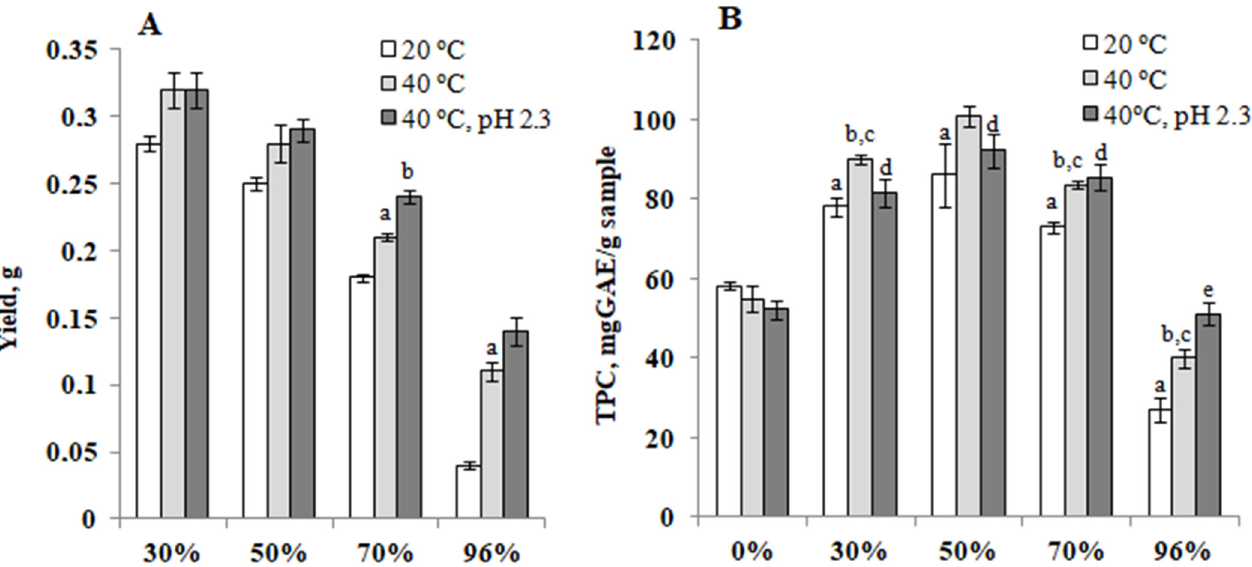
Figure 6. ( A )—The extract yield (g) per 1 g of dry powder of leaves depending on the temperature and pH. a —Significantly different from the water-ethanol extracts, 20 ◦ C ( p < 0.05); b —significantly different from the water-ethanol extracts, 40 ◦ C ( p < 0.05). ( B )—Content of phenolic compounds (mg GAE/g of extract) in water-ethanol extracts of yacon leaves, depending on temperature and pH. a —Significantly different from the 0% ethanol, 20 ◦ C ( p < 0.05); b —significantly different from the 0% ethanol, 40 ◦ C ( p < 0.05); c —significantly different from the water-ethanol extracts, 20 ◦ C ( p < 0.05); d —significantly different from the 0% ethanol, 40 ◦ C ( p < 0.05); e —significantly different from the water-ethanol extracts, 40 ◦ C ( p < 0.05).